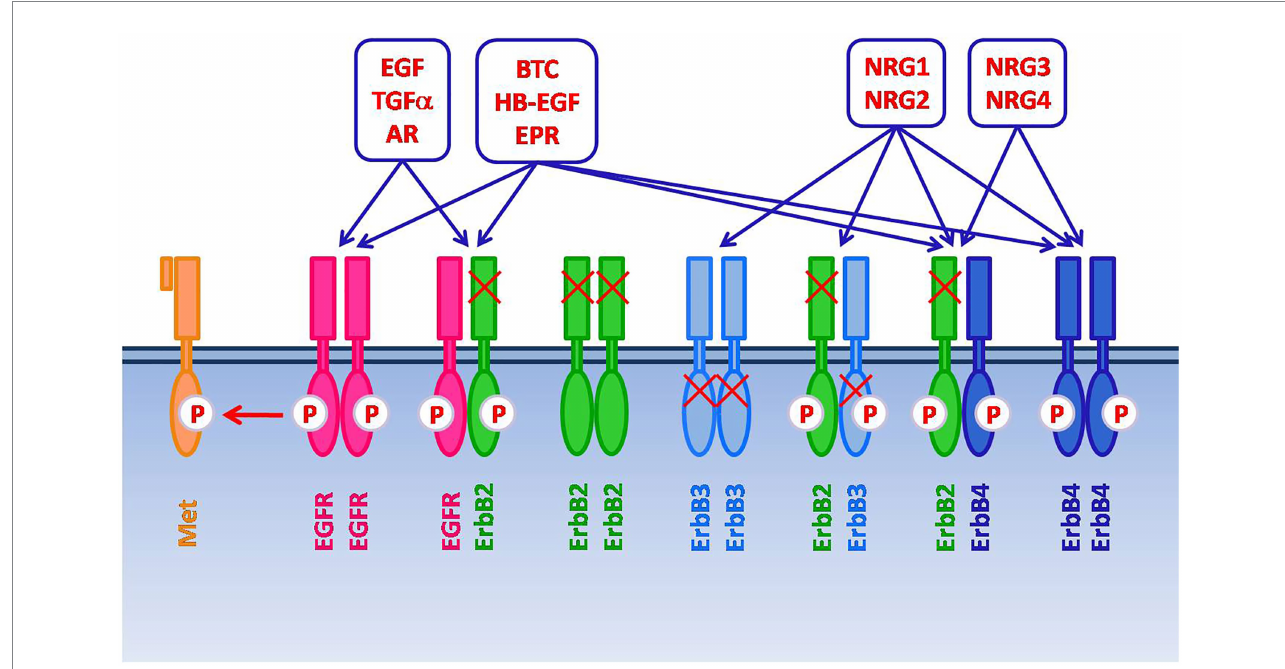
FIGURE 1 The ErbB/HER family of receptor tyrosine kinases includes four members: EGFR (HER1, ErbB1), ErbB2, ErbB3, and ErbB4 (HER2-4). After the binding with the cognate ligands, ErbB receptors form homo- and heterodimers/oligomers in various combinations. This leads to receptor trans/autophosphorylation and the activation of signaling cascades, resulting in proliferation, differentiation, cell motility, and cell death inhibition. Several ligands have been described, including Epidermal Growth Factor (EGF), Transforming Growth Factor-alpha (TGF- α ), Amphiregulin (AR), Betacellulin (BTC), Heparin Binding Epidermal Growth Factor (HB-EGF), Epiregulin (EPR), and Neuregulins (NRGs). The specific ligands for EGFR are EGF, TGF- α and AR. NRG1-2 bind to ErbB3. BTC, HB- EGF, EPR, NRG1-4 bind to ErbB4. BTC, HB-EGF and EPR can also bind to EGFR. ErbB2, which does not have a direct ligand, and ErbB3, which has impaired kinase activity, signal via heterodimerization with other members of the family. Moreover, spontaneous dimerization of ErbB2 can occur due to the receptor overexpression. EGFR can also form heterodimers with receptor tyrosine kinases that do not belong to the ErbB family, such as the HGF receptor